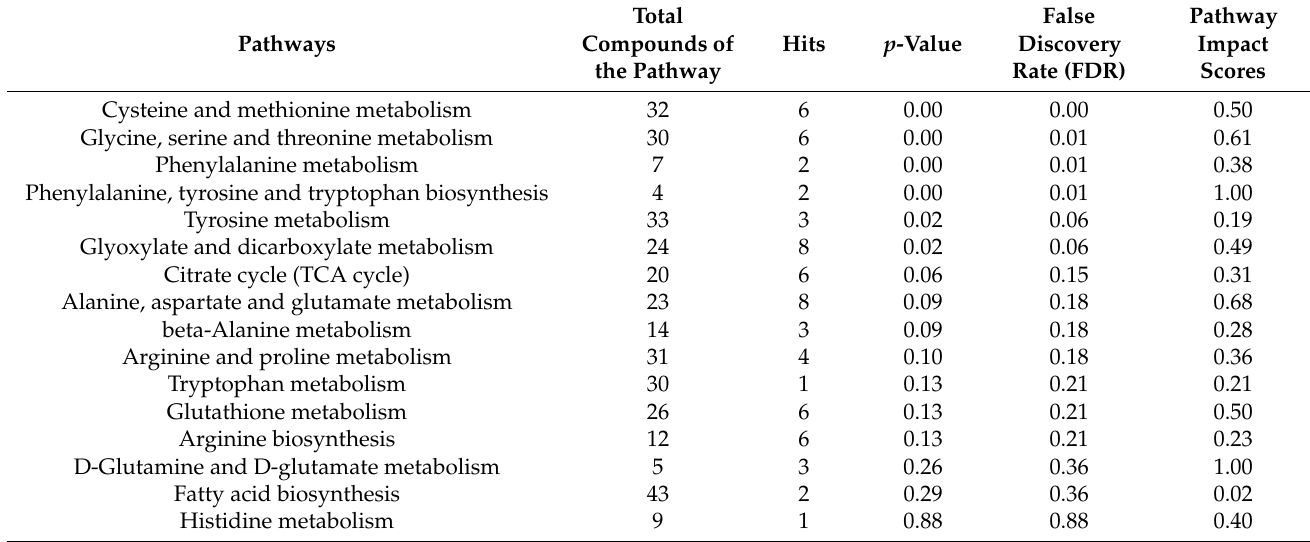
Fatty acid biosynthesis